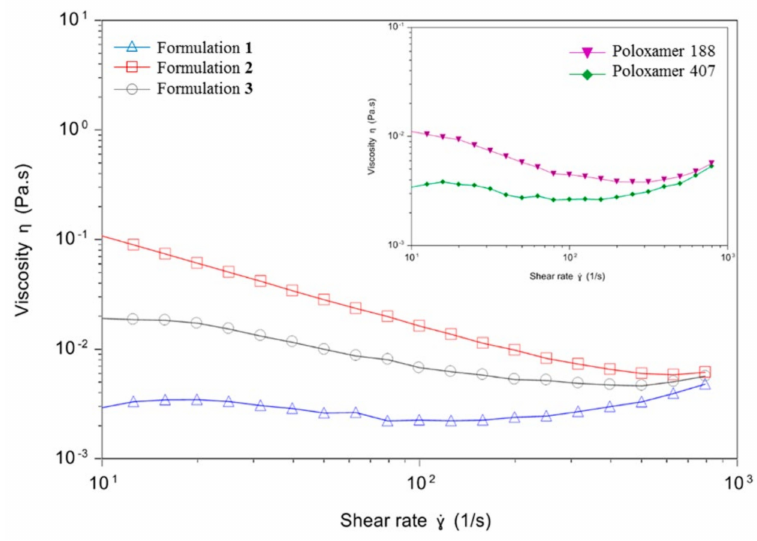
Figure 3. Rheology measurements. Main graph: viscosity curves of niosomes based on formulations 1 (blue line, triangles), 2 (red line, squares) and 3 (grey line, dots) expressed as a function of shear rate. Secondary graph: viscosity curves of poloxamer 188 (violet line, inverted triangles) and poloxamer 407 (green line, rhombus) expressed as a function of shear